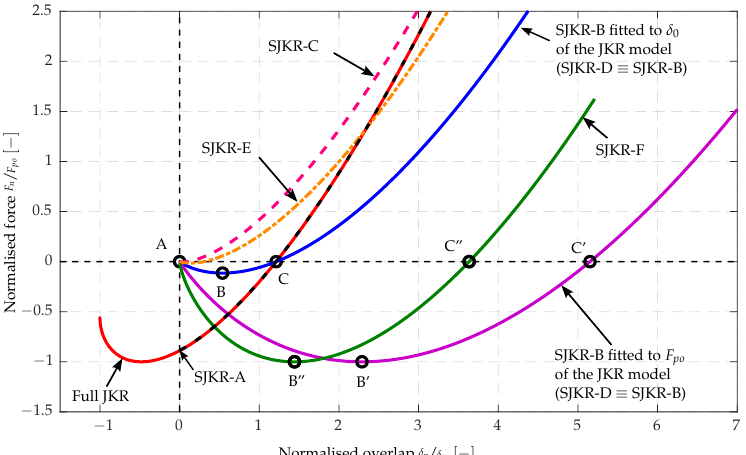
Figure 5. The load-displacement curve of the full JKR, SJKR-A, SJKR-B, SJKR-C, SJKR-D, SJKR-E and SJKR-F models. The parameters are normalised using F po and δ to from the full JKR theory (Section